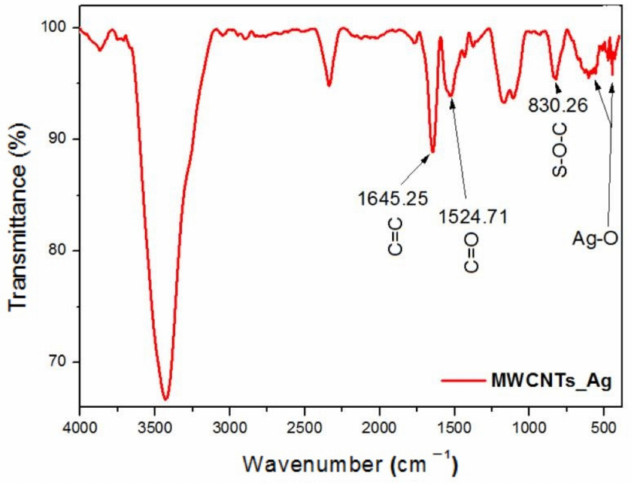
Figure 2. FTIR spectra of the MWCNTs_Ag.